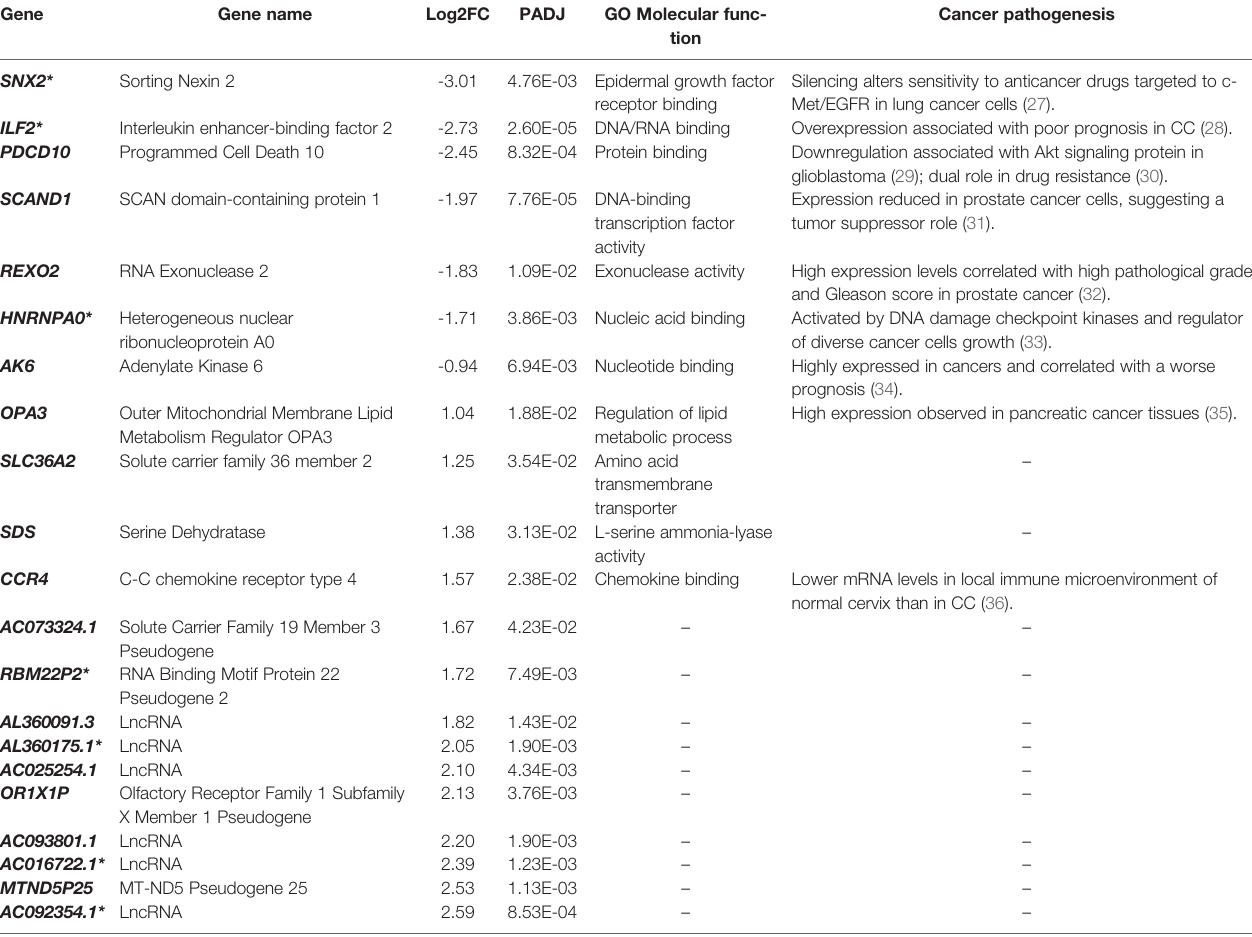
TABLE 2 | Description of the 21 highest values of pAUC (partial area under the ROC curve) from the differential expression genes of cervical cancer stem-like cells in patients with responsiveness (n=21) and failure (n=10) to chemoradiotherapy (NR vs